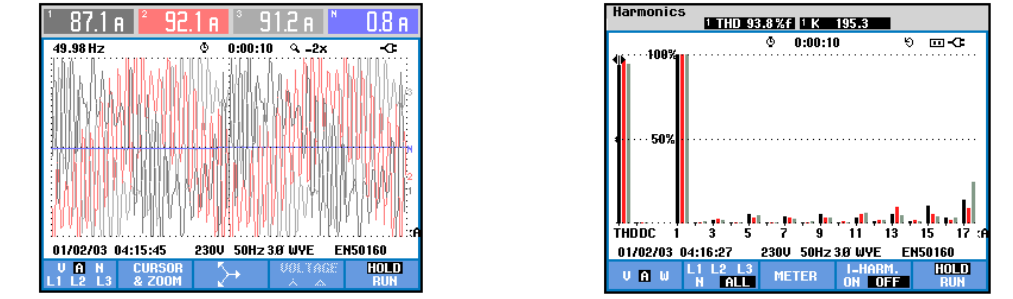
Figure 24. Waveforms of grid current and its harmonic spectra with common control strategy shunt APF prototype after parallel capacitance load is connected at the point of common coupling (PCC).